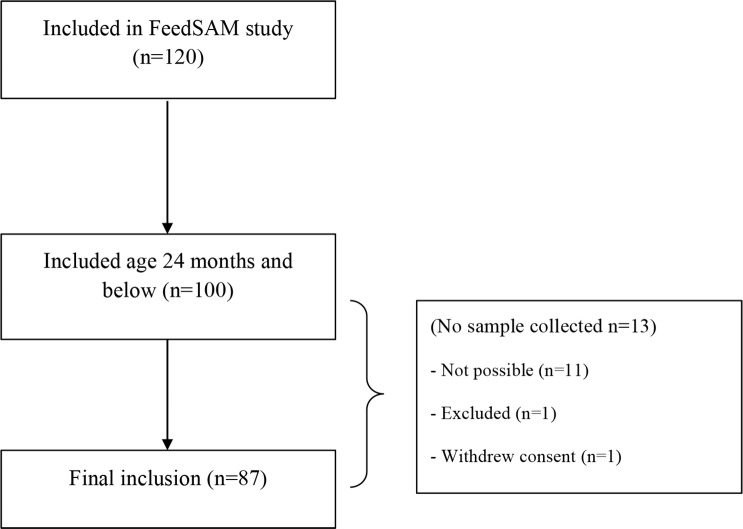
Enrollment.Flow diagram of the final number of children included in the study.